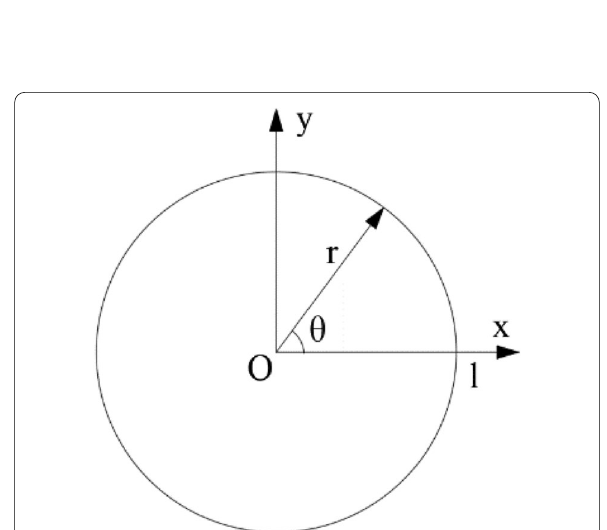
Figure 3 Transverse oscillation of circular